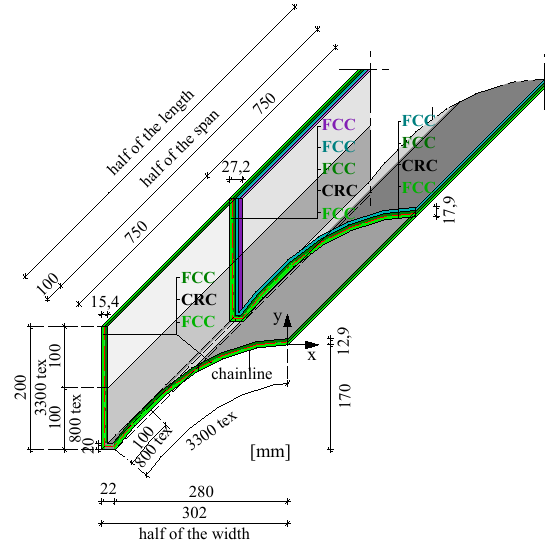
Figure 4. Cross section layups of reinforced shell sections consisting of 3300 tex and 800 tex fabrics, fleece concrete composite (FCC) and carbon reinforced concrete (CRC) displayed for a quarter section of the girder corresponding to the two planes of symmetry [24].